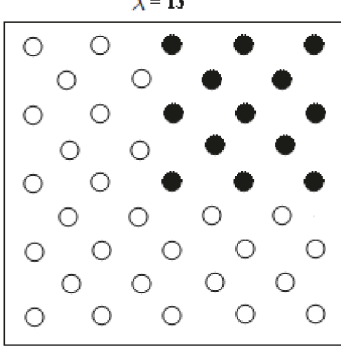
Figure 9: Node ASF ( 𝛾 𝜆 ∘ 𝜙 𝜆 ) ∘ ( 𝛾 𝜆 ∘ 𝜙 𝜆 ) for 𝜆 𝑚𝑎𝑥 .